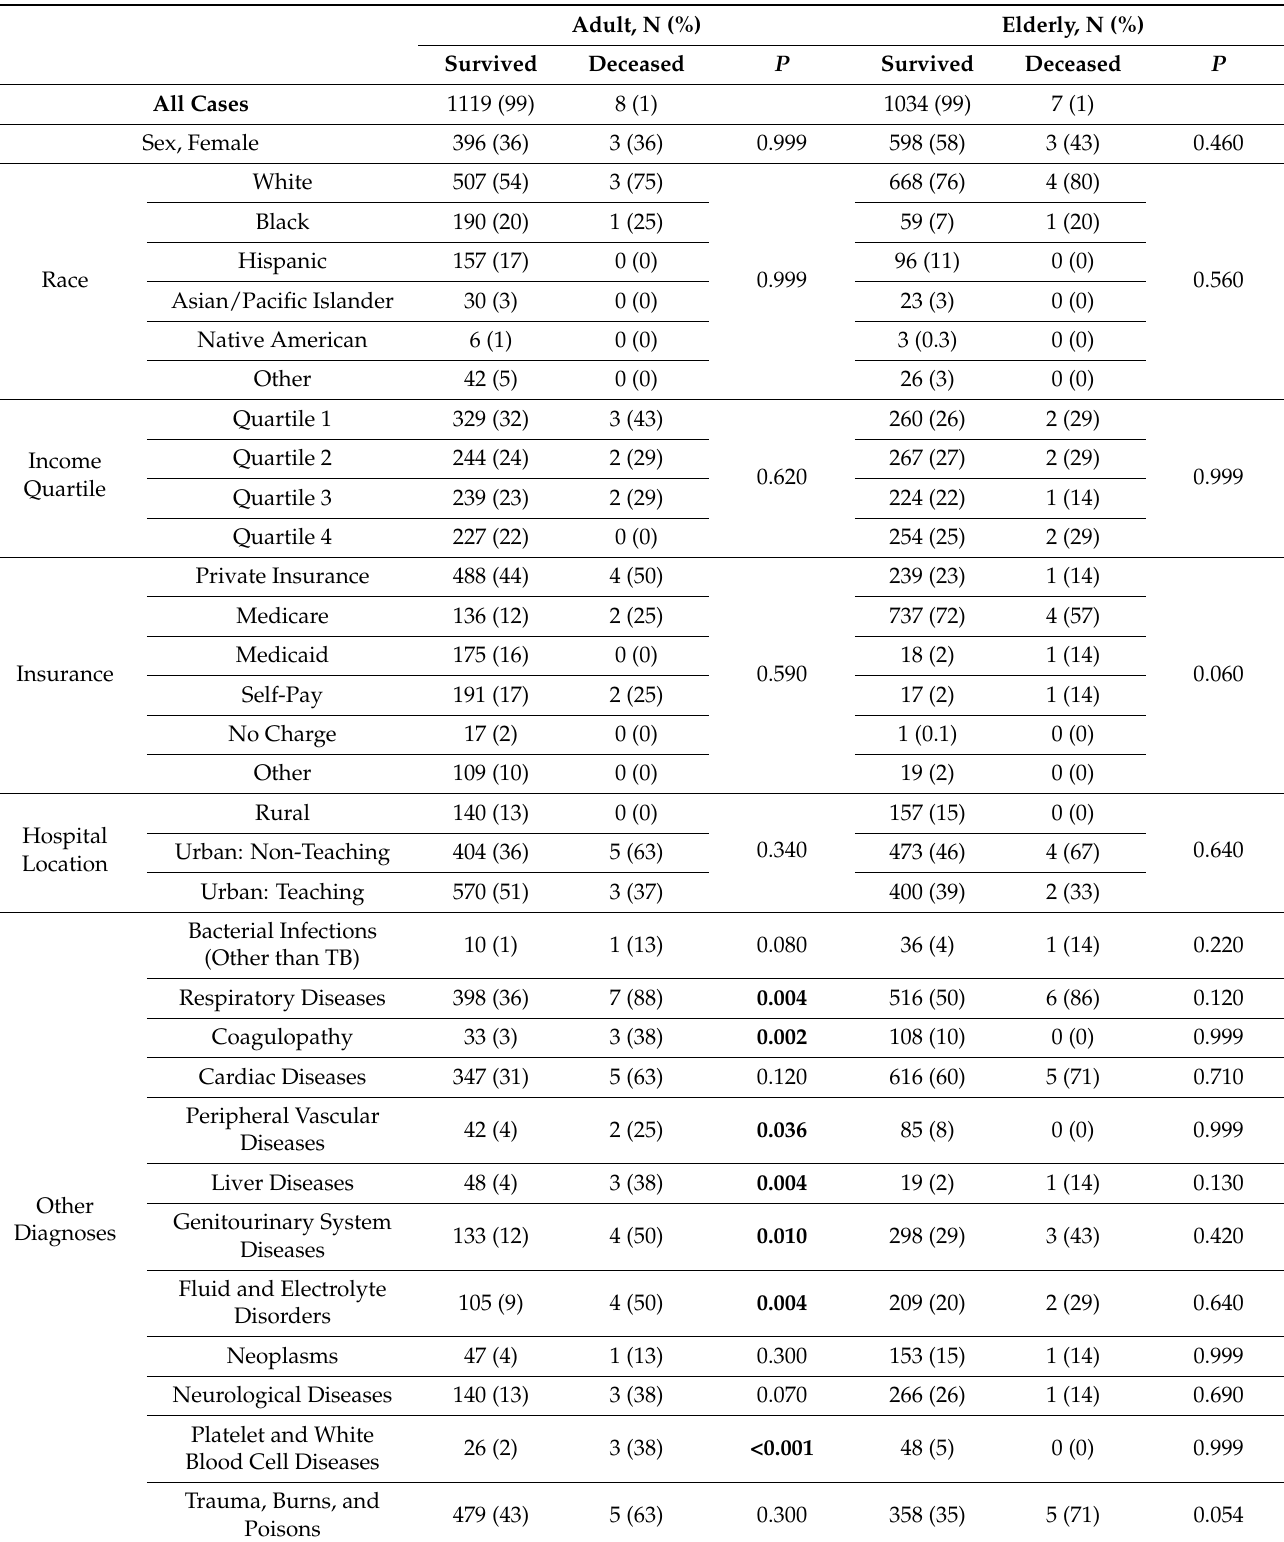
Table 2. Characteristics of emergently admitted patients with a primary diagnosis of blunt chest wall injury. Data are classified according to outcome categories, NIS